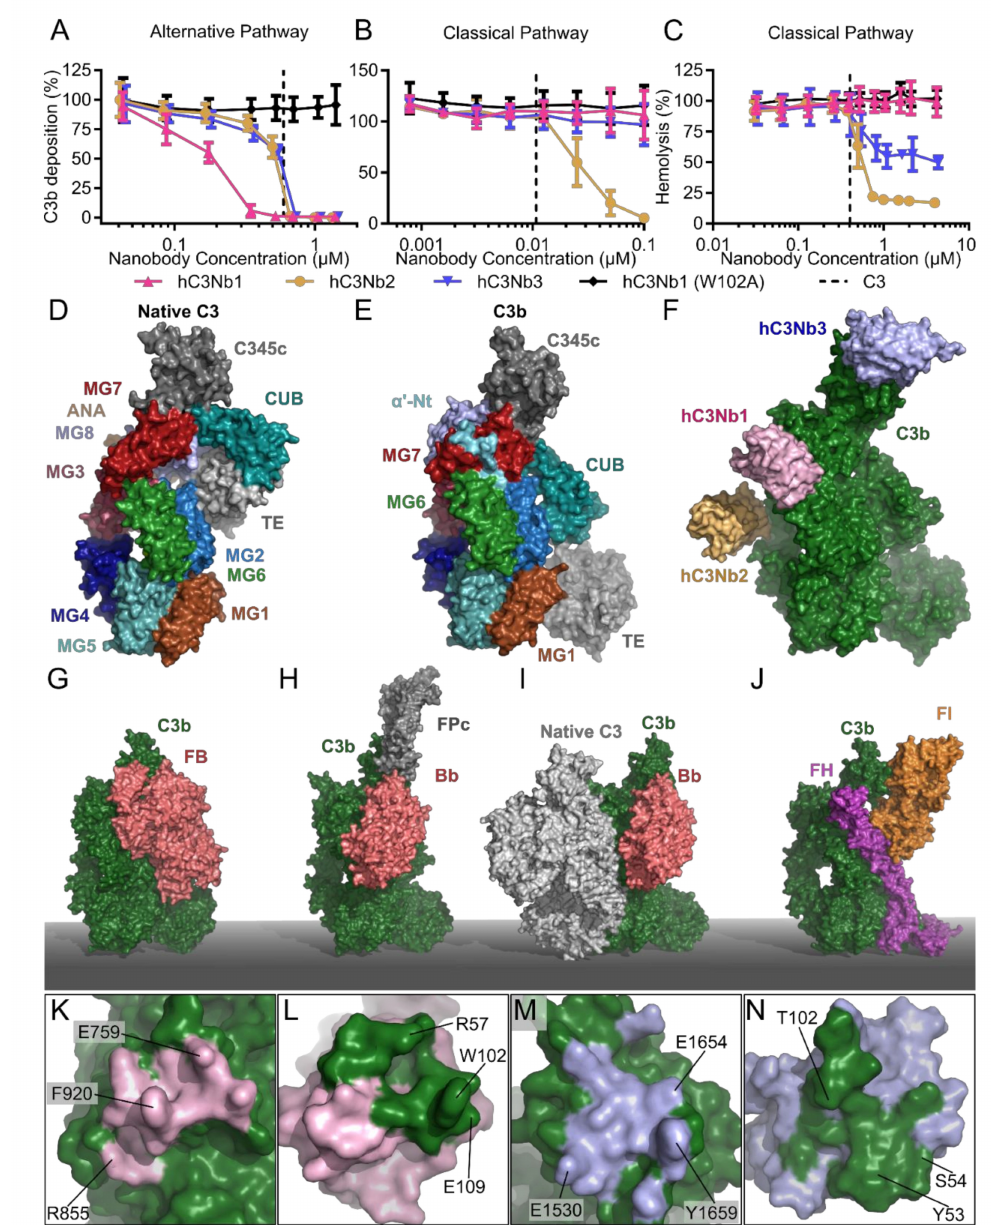
Figure 5. The C3 specific nanobodies. C3 fragment deposition assay elicited by ( A ) the AP in 11% NHS or ( B ) the CP in 0.2% NHS demonstrating the effect of the C3 specific nanobodies: hC3Nb1 (AP inhibitor), hC3Nb2 (CP/LP/AP inhibitor), hC3Nb3 (AP inhibitor) as well as the inactive hC3Nb1 (W102A) mutant. ( C ) Classical pathway mediated hemolysis assay in 7.5% NHS comparing the effects of hC3Nb1, hC3Nb2, hC3Nb3 and hC3Nb1 (W102A). Dashed lines in panels ( A – C ) indicate the putative C3 concentration in the assays. Surface representation of ( D ) native C3 (PDB entry 2A73) and ( E ) C3b (PDB entry 5FO7). Labels indicate the location of the individual domains in panels ( D , E ). ( F ) The proposed binding site of hC3Nb2 as well as the crystal structure of the hC3Nb3 (PDB entry 6XZU) were docked onto the crystal structure of hC3Nb1 in complex with C3b (PDB entry 6EHG). Crystal structures of ( G ) the AP C3 proconvertase (PDB entry: 2XWJ), and ( H ) the properdin stabilized AP C3 convertase (PDB entry: 6RUR). ( I ) The substrate recognition model of the C3 convertases, where C3 (PDB entry 2A73) and C3bBb (PDB entry: 2WIN) were docked into the structure of the CVF:C5 complex (PDB entry: 3PVM). ( J ) The crystal structure of the C3b:FI:mini-FH complex (PDB entry 5O32). ( K , L ) Interaction sites indicated as footprints of ( K ) hC3Nb1 on C3b, ( L ) C3b on hC3Nb1, ( M ) hC3Nb3 on C3b, and ( N ) C3b on hC3Nb3. Labels indicate selected residues in antigen and nanobody of importance for the